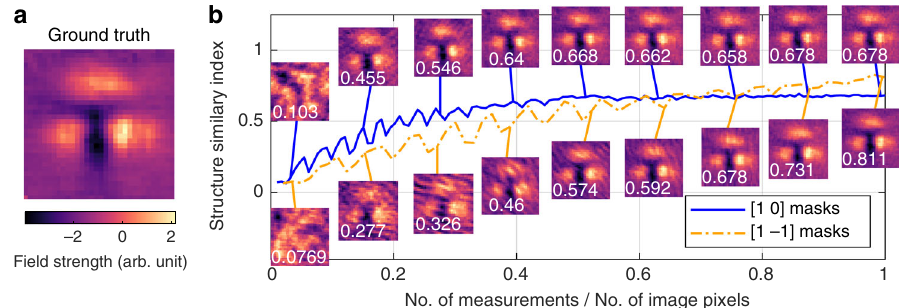
Fig. 4 Hadamard Undersampling. a The image used as the ground truth for undersampling investigations; an average of 9 images taken consecutively. b Structure similarity index (SSIM) as a function compression ratio (number of mask measurements/number of image pixels). Solid-blue (dash dotted- yellow) line is data from [1 0] ([1 − 1]) Paley – Hadamard masks (see Supplementary Fig. 4 for mask examples). Some images at various compression ratios are shown with a solid line indicating the sampling ratio of the image. Note, the optical delay line was fi xed at the peak of the THz fi eld